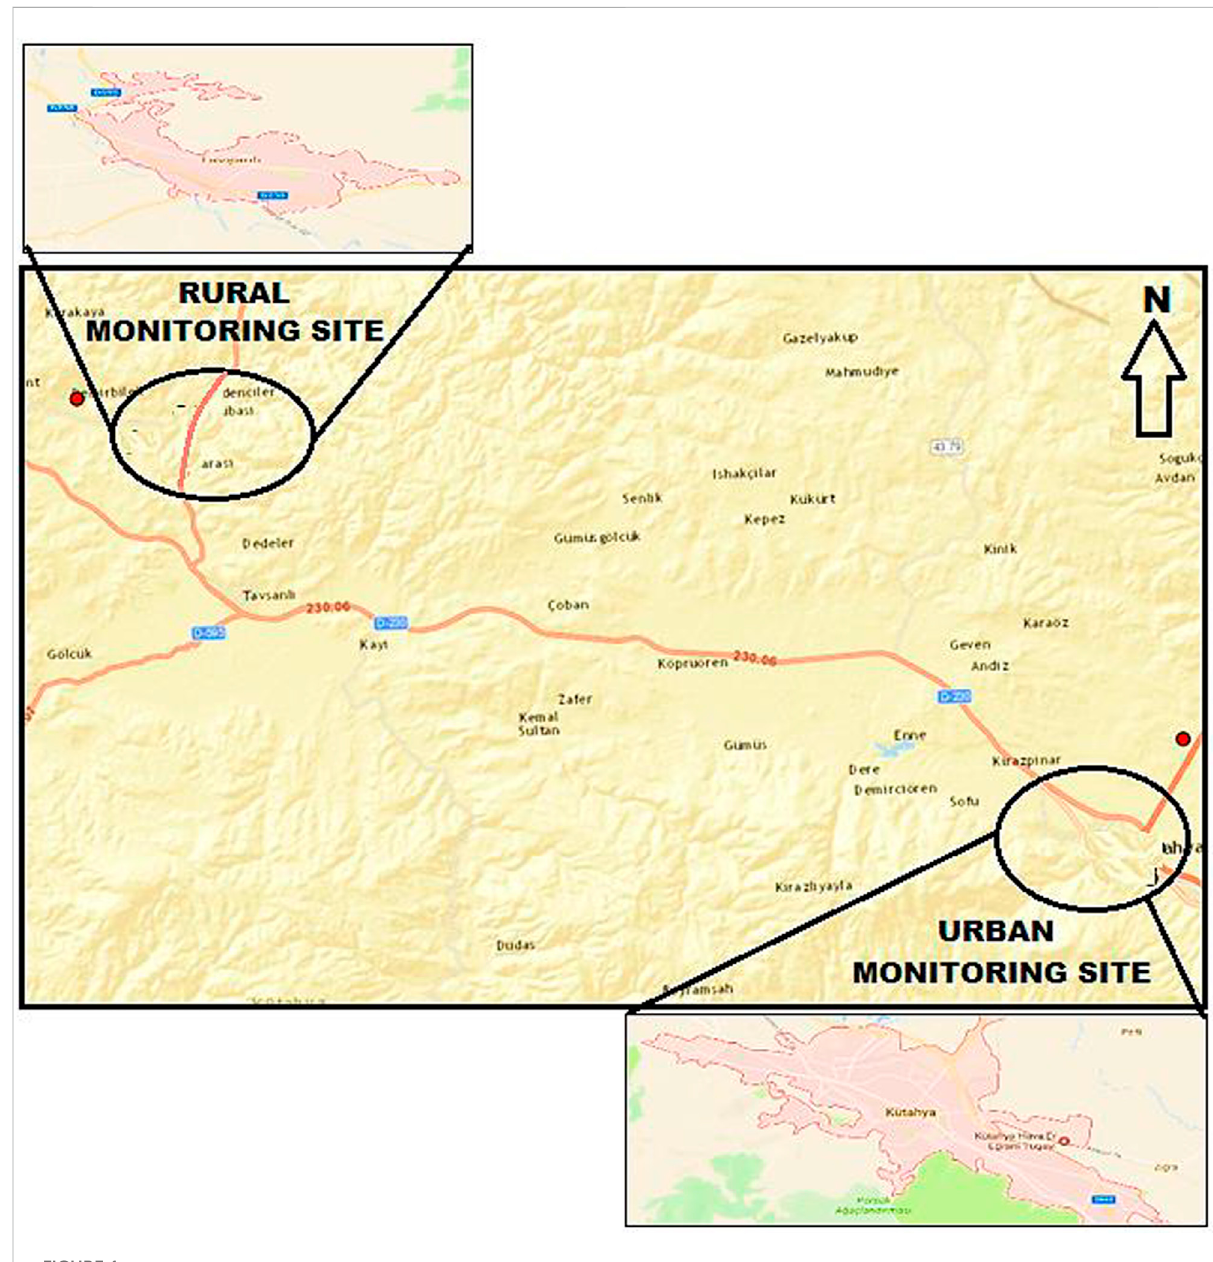
FIGURE 1 Map of the study area showing the locations of the two monitoring